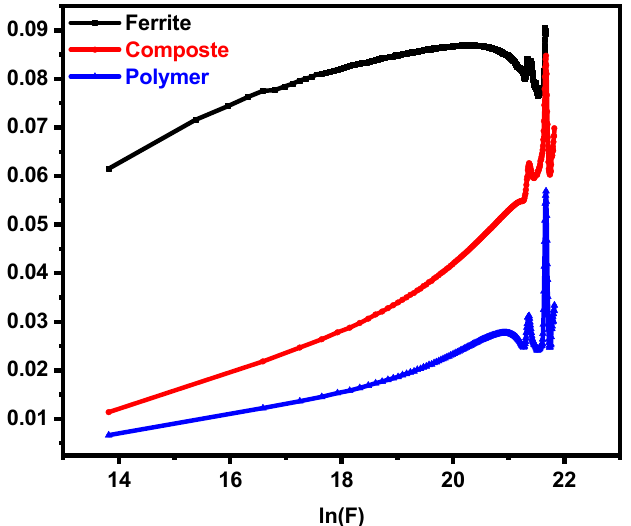
Figure 8. Variation in the real part of electric absolute value with the frequency of Y-type hexaferrite Sr 2 Co 2 Fe 12 O 22 , composite (Sr 2 Co 2 Fe 12 O 22 + PPy-DBSA) and polymer PPy-DBSA.